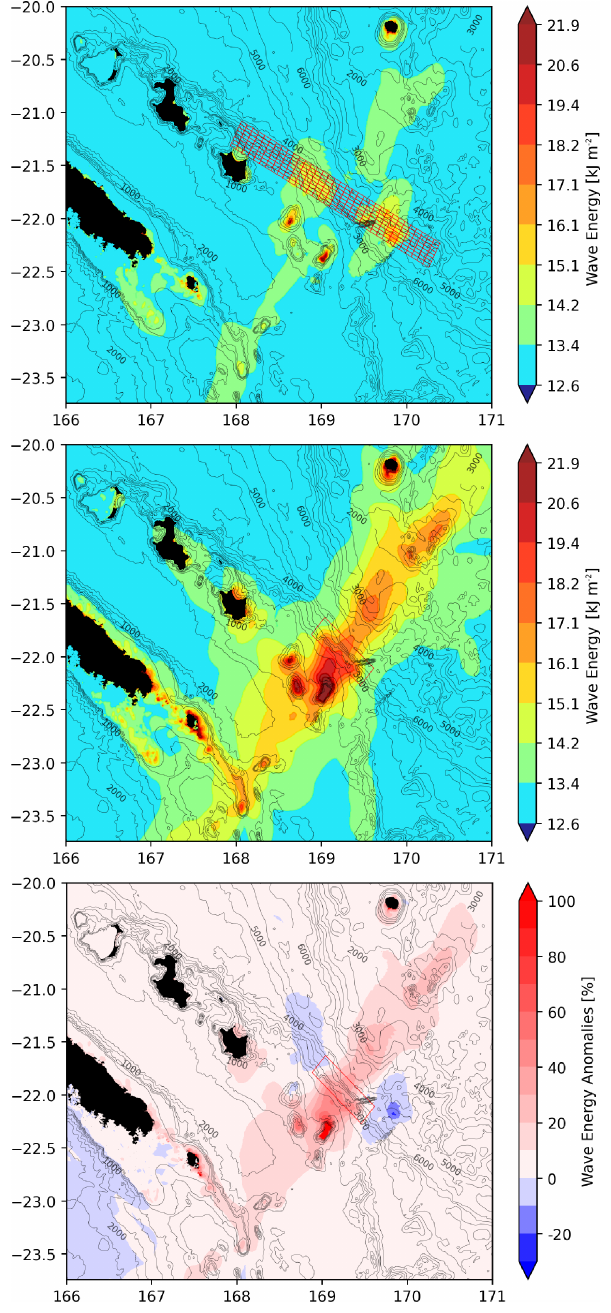
Figure 6. Total wave energy maps for two different models – NUM with a strike angle of 298 ◦ (top panel), UM with a strike angle of 312 ◦ (middle panel) – and the relative energy anomaly between the two (bottom panel). The bathymetric contours underline the features playing a possible role in tsunami wave propagation. The extent of the sources is symbolized with the red rectangles: small boxes (top panel) denote the 272 fault segments solution from USGS where heterogeneous slip distribution (NUM) is applied along a 270km long rupture fault. In the UM case (middle panel), uniform slip de- formation is applied over the 80km long rupture